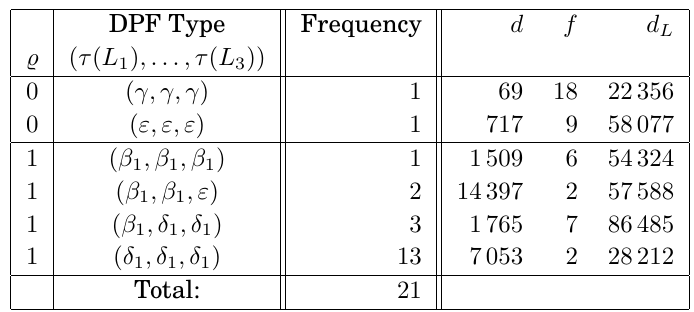
Table 4: Types of triplets in the range 0 < d L < 10 5